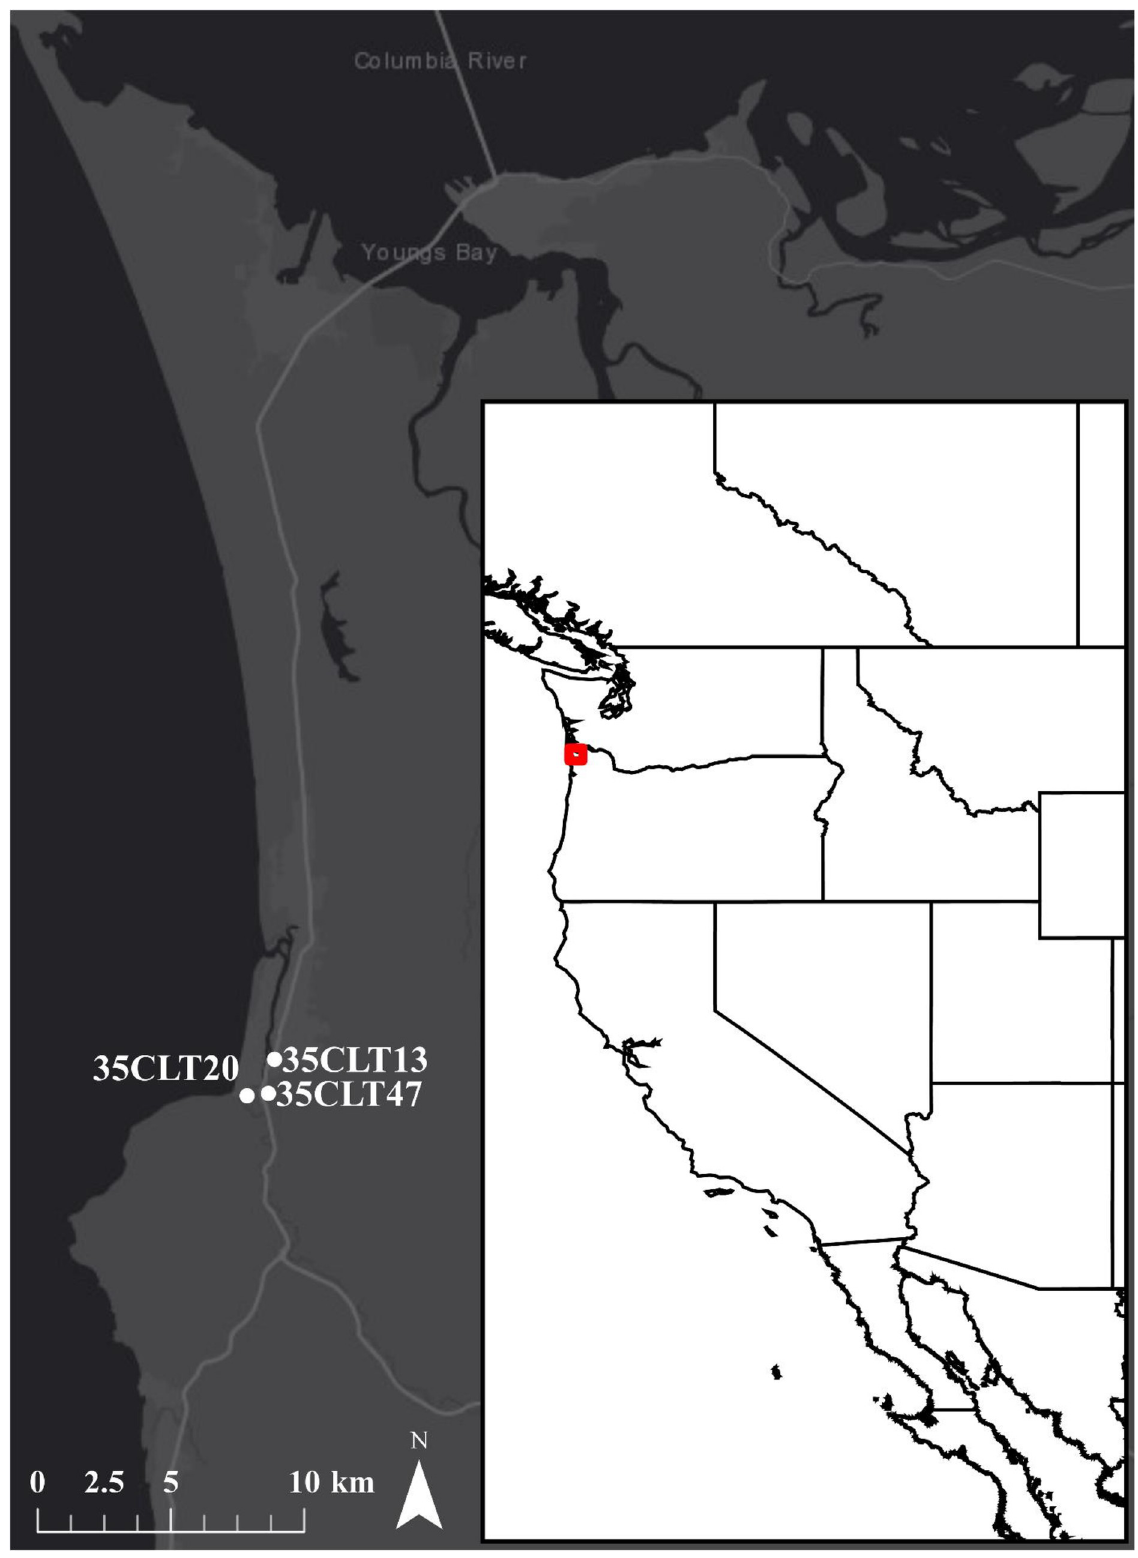
Fig 1. Overview of the northern Oregon Coast and the location of the Palmrose (35CLT47), Par-Tee (35CLT20), Avenue Q (35CLT13) sites. https://doi.org/10.1371/journal.pone.0255223.g001 PLOS ONE | https://doi.org/10.1371/journal.pone.0255223 August 17,